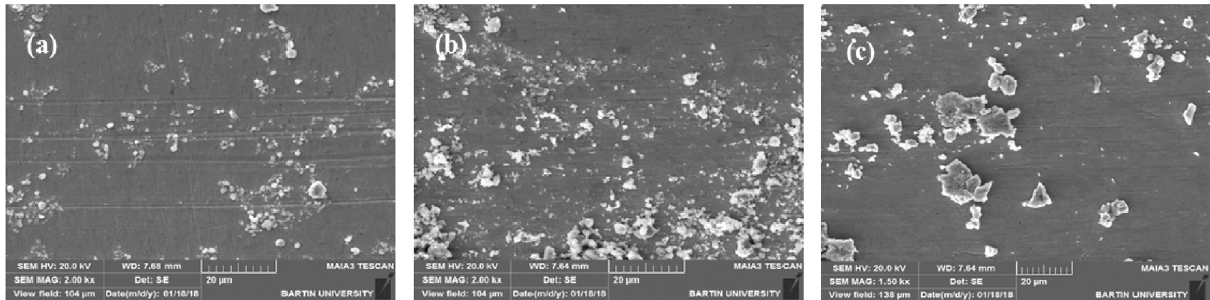
Fig. 7 SEM morphologies of the wear surfaces of CoCrFeNiTi 0.5 alloy specimens at (a) room temperature, (b) 250 ° C, and (c) 500 °